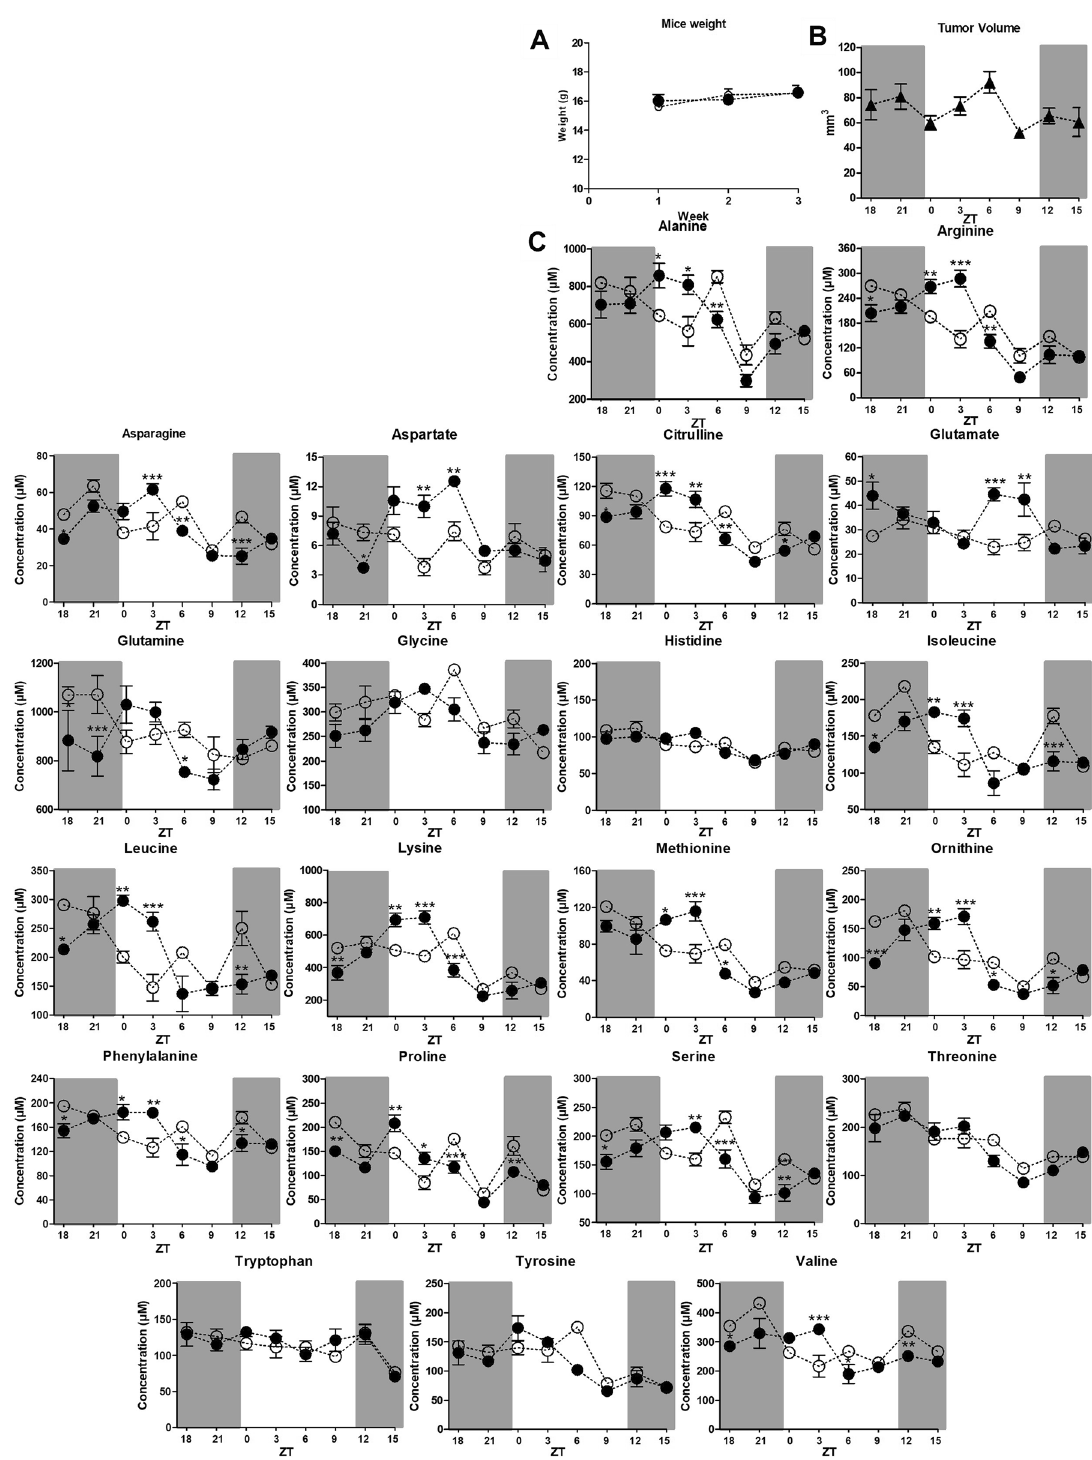
Figure 2. Body weight, tumor volume and plasma amino acids concentrations in mice. ( A ) Mice weight represented by the mean ± S.E.M across three weeks of tumor hosting. ( B ) Tumor volume represented by the mean ± S.E.M in each time point when mice were bled. ( C ) In vivo AAs detected in tumor-bearing animals (black circles) compared to control (white circles). On the horizontal axis the numbers indicate eight time points, Zeitgeber time (ZT), across a normal diurnal variation with 12 h in light phase (clear background) and 12 h in dark phase (dark background), starting at ZT18 and finishing at ZT15. The data represent the mean ± S.E.M. comparing tumor-bearing animals vs non-tumor-bearing animals. * p < 0.01, ** p < 0.001, *** p <